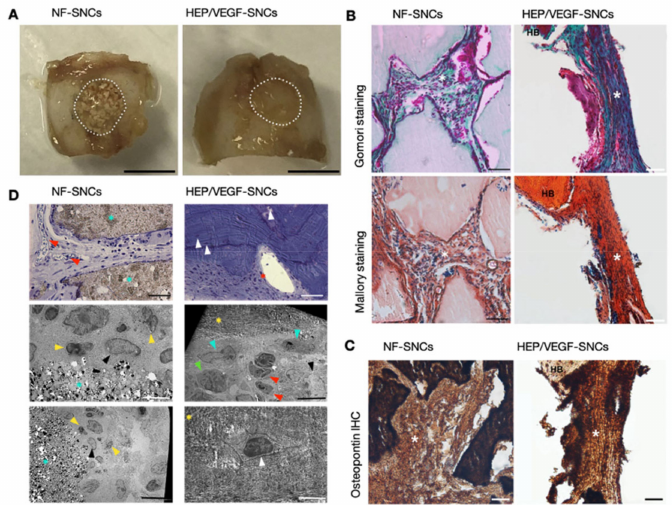
Figure 4. Bone regeneration in critical-sized calvarial bone defects implanted with bone substitutes. ( A ) Macroscopic evaluation of the calvarial bones at 4 wpi implanted with either NF- or HEP/VEGF- SNCs. Scale bar: 5 mm. ( B ) Gomori and Mallory stains of sections of the calvarial bones implanted with either NF- or HEP/VEGF-SNCs. In Gomori trichrome stain, collagen is light blue, erythrocytes are pink, osteoblasts/osteocytes are violet/brown; in Mallory trichrome stain, cartilage is blue, bone components are orange to red and nuclei are brown. HB: Healthy bone; white asterisk: newly-formed bone within the implanted bone substitute. Scale bar: 50 µ m. ( C ) Sections of the specimens shown in ( B ) underwent immunohistochemistry analyses against Osteopontin. HB: healthy bone. Scale bar: 50 µ m. ( D ) Toluidine blue staining on semi-thin sections (upper panels) and transmission electron micrographs on ultrathin sections (mid and lower panels). Red arrowhead: capillary; white arrowhead: osteocyte; cyan arrowhead: osteoblast; yellow arrowhead: granulocyte; black arrowhead: megakaryocyte; green arrowhead: erythroblast; red asterisk: capillary lumen with blood cells; cyan asterisk: mineral part of the biphasic bone substitute; yellow asterisk: bone matrix. Scale bar: 25 µ m (upper panels); 10 µ m (mid panels), 5 µ m (lower